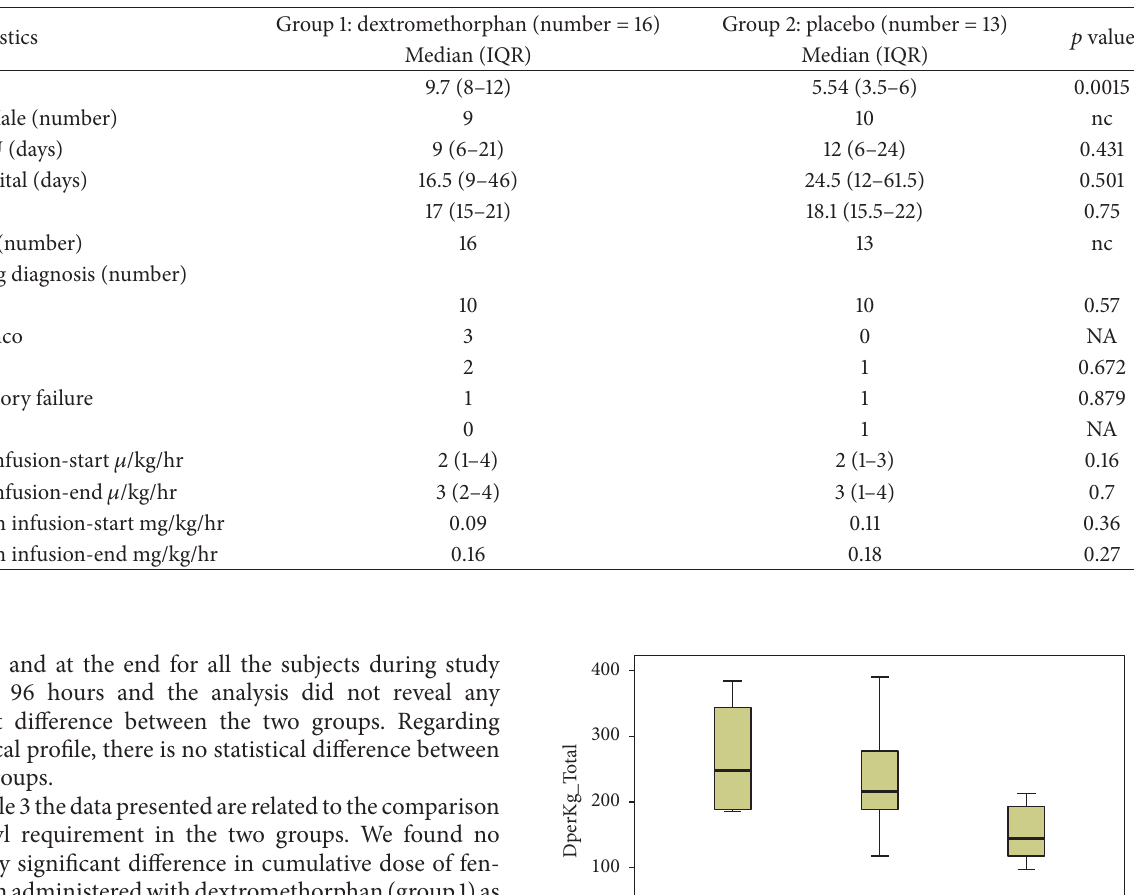
Table 1: Demographic characteristics. Clinical Outcomes of subjects in Groups 1 and 2 in RCT. Kolmogorov-Smirnov test used to assess distribution. nc, not computed.